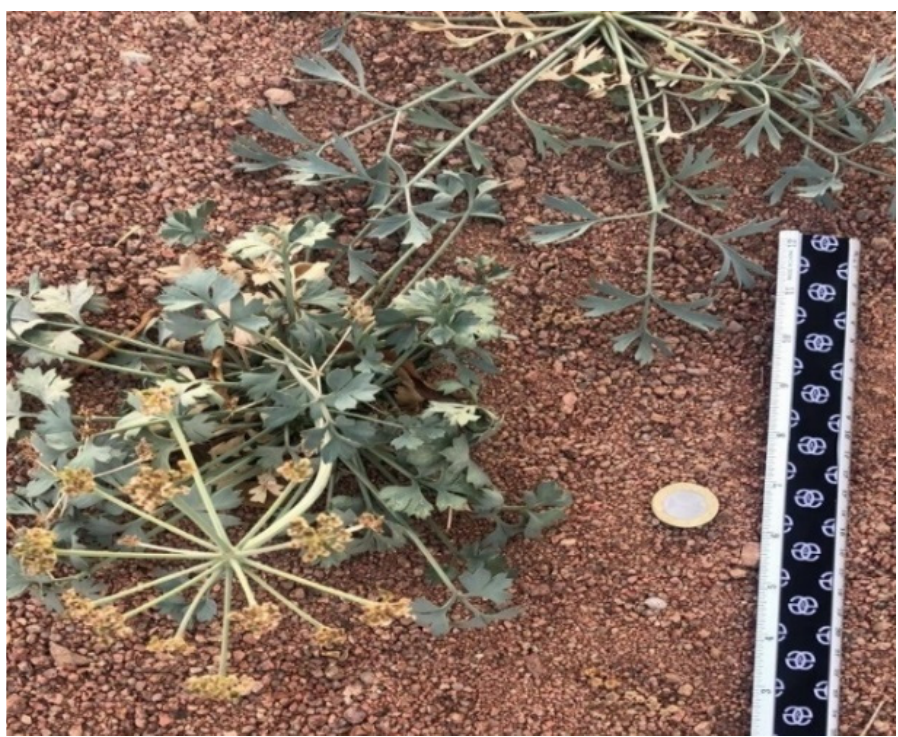
Figure 4. Al-Haza plant species collected from Al-Mu’ayqilat (Hail region).